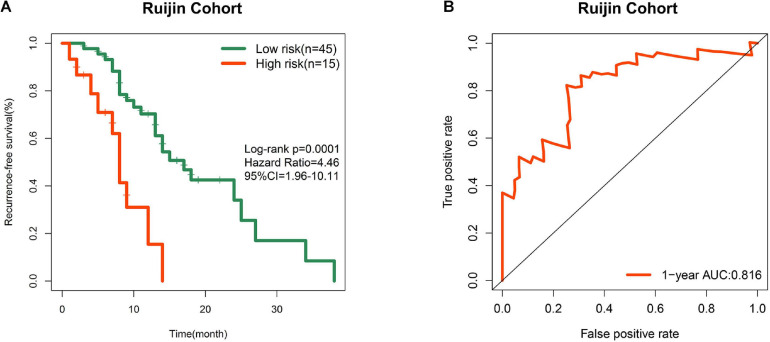
Prognostic validation in a local cohort. (A) K-M curve of RFS in Ruijin cohort. (B) ROC curve of the signature in predicting 1 year RFS in Ruijin cohort.